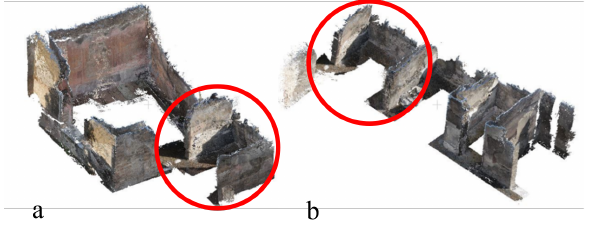
Figure 4. Two point clouds (a) and (b) deriving from two blocks of images and the common overlapping part (in the red circles).